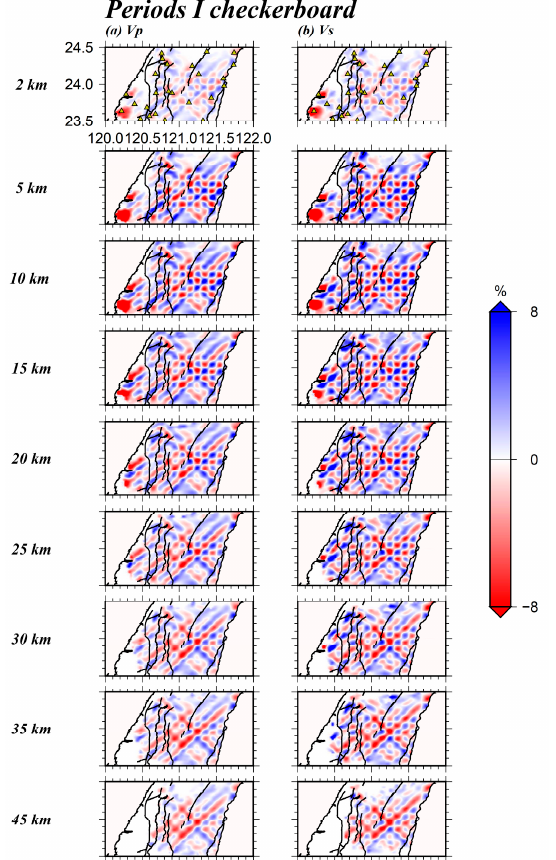
Figure 2. Perturbations of ±8% of Vp and Vs were added to generate a new 3D velocity model in the form of a checkerboard (grid distance: 10 × 10 km 2 ). Yellow triangles represent the stations. ( a ) Period I checkerboard of Vp. ( b ) Period I checkerboard of Vs.